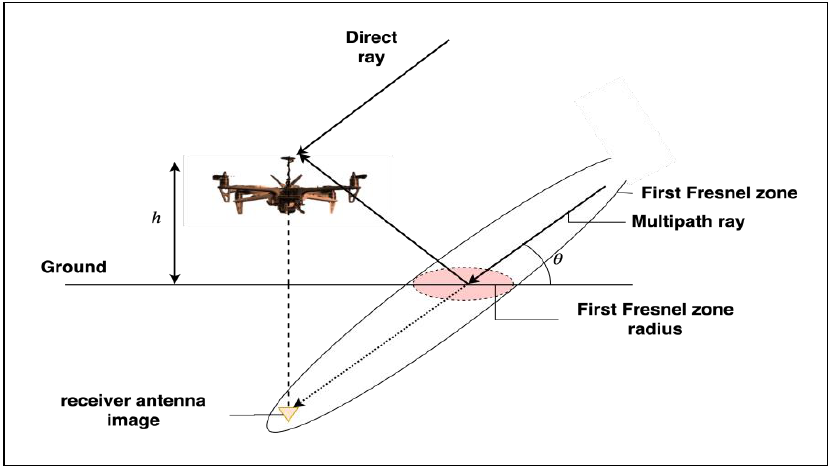
Figure 6. Ground reflection.